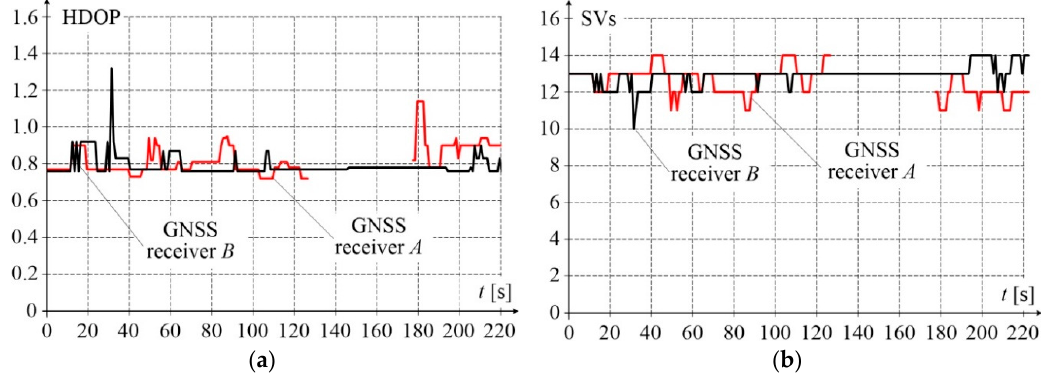
Figure 4. Measurement quality indicators of receivers A and B : ( a ) HDOP characterising the position accuracy in 2D space; ( b ) number of space